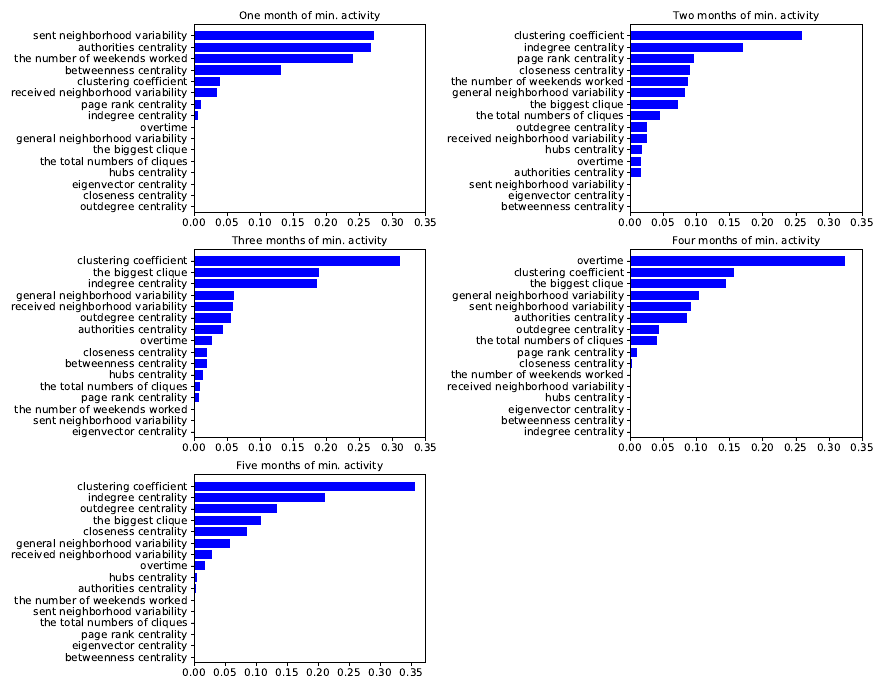
Figure A1. Features importance (Gini importance) for the Decision Tree which uses the full set of features for the manufacturing company dataset with two levels of the hierarchy.